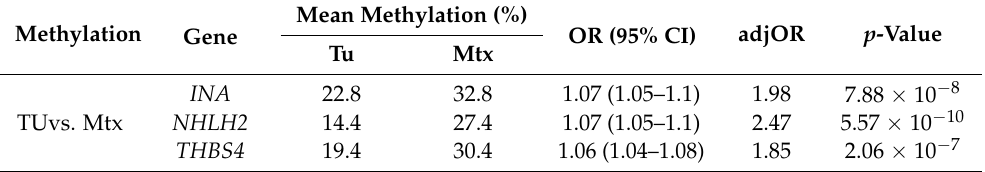
Figure 4. ( a ) Strip chart presentation of the hypermethylation analysis of INA, NHLH2 , and THBS4 in paired adjacent normal tissue (adN) and renal tumors (TU) samples. The corresponding statistical analysis revealed significant tumor-specific hypermethylation for all candidate genes ( p = 3.72 × 10 − 24 , 3.17 × 10 − 13 , 1.58 × 10 − 19 ). ( b ) Box plot of INA, NHLH2 , and THBS4 methylation in independent tissue sample groups representing localized primary tumor and metastatic tissue samples. All of the candidate genes demonstrated metastatic tissue-specific hypermethylation ( p = 7.88 × 10 − 8 , 5.57 × 10 − 10 , 2.06 × 10 − 7 respectively). Table 4. Statistical association of INA, NHLH2, and THBS4 methylation and metastatic tissue in logistic regression